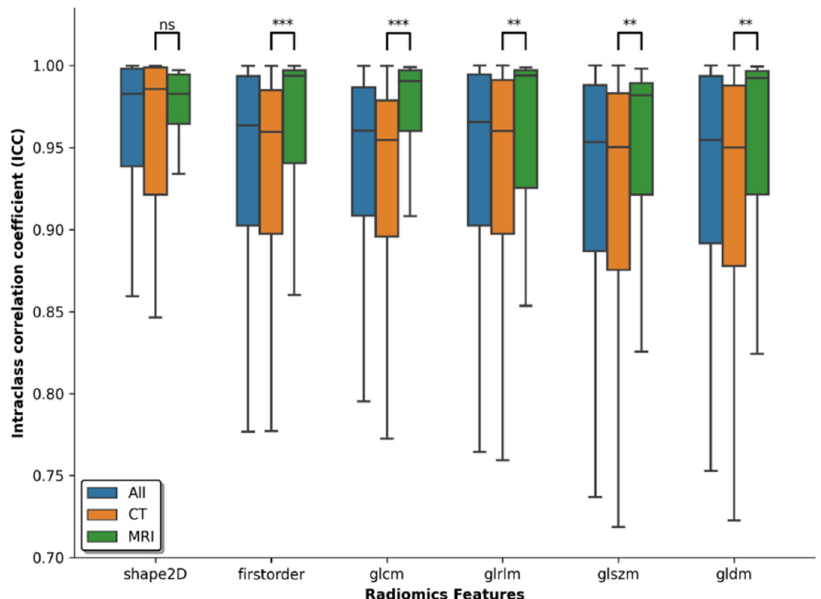
Figure 4. Reliability of radiomic features as a function of feature group and imaging modality. Features were grouped into shape features (“shape2D”), first-order features (“firstorder”), and gray- level matrix features, i.e., Gray Level Co-occurrence Matrix (“glcm”), Gray Level Run Length Matrix (“glrlm”), Gray Level Size Zone (“glszm”), and Gray Level Dependence Matrix (“gldm”). Imaging modalities are color-coded as follows: orange, only CT data; green, only MRI data; blue, all (CT and MRI). No consistent trends were found across the datasets, thus stressing the importance of analyzing feature reliability individually for each feature and modality. Asterisks denote statistical differences between the CT and the MRI dataset. ns: not significant, ** p < 0.01, *** p < 0.001.